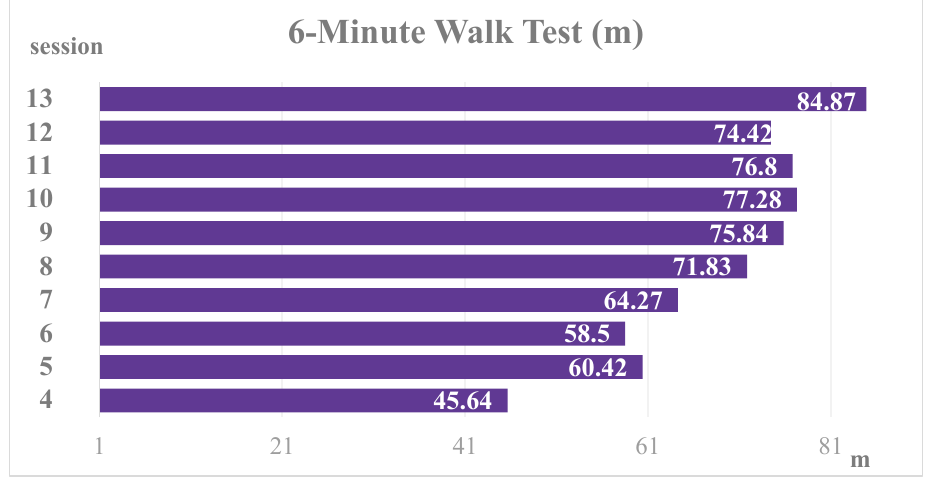
Figure 3. Trend of six MWT.